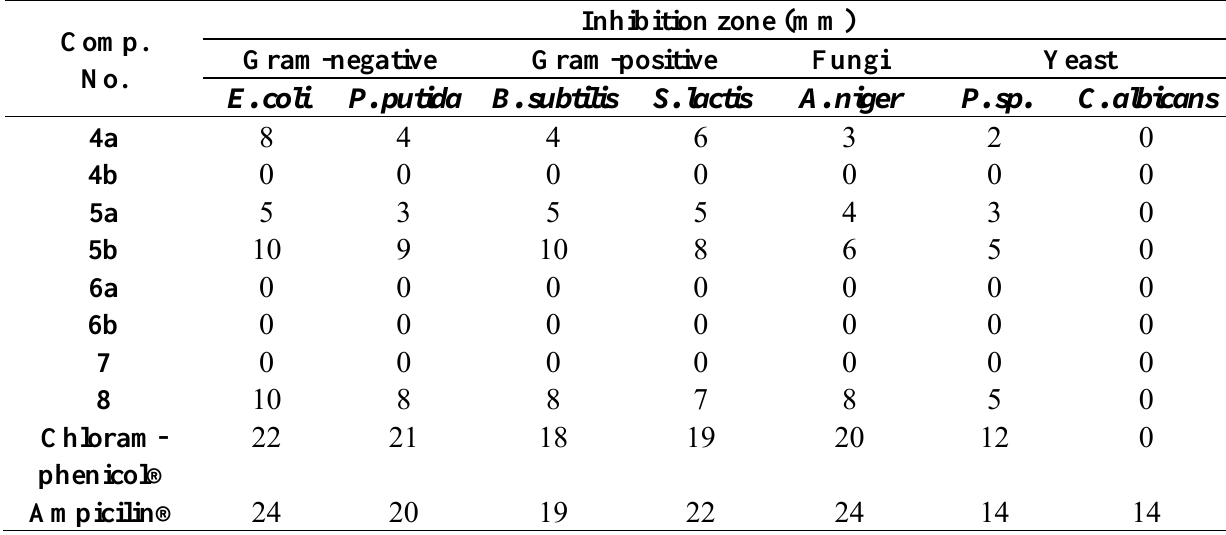
Table 1. Antimicrobial activities of the newly synthesized